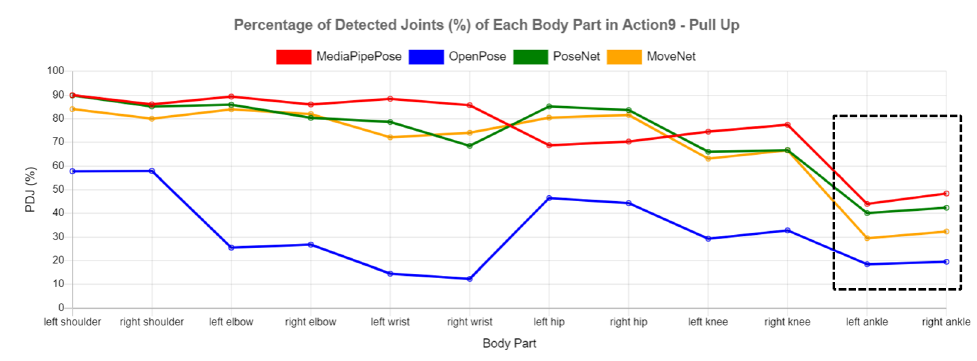
Figure 13. PDJ for each body part in Action 9–pull up.